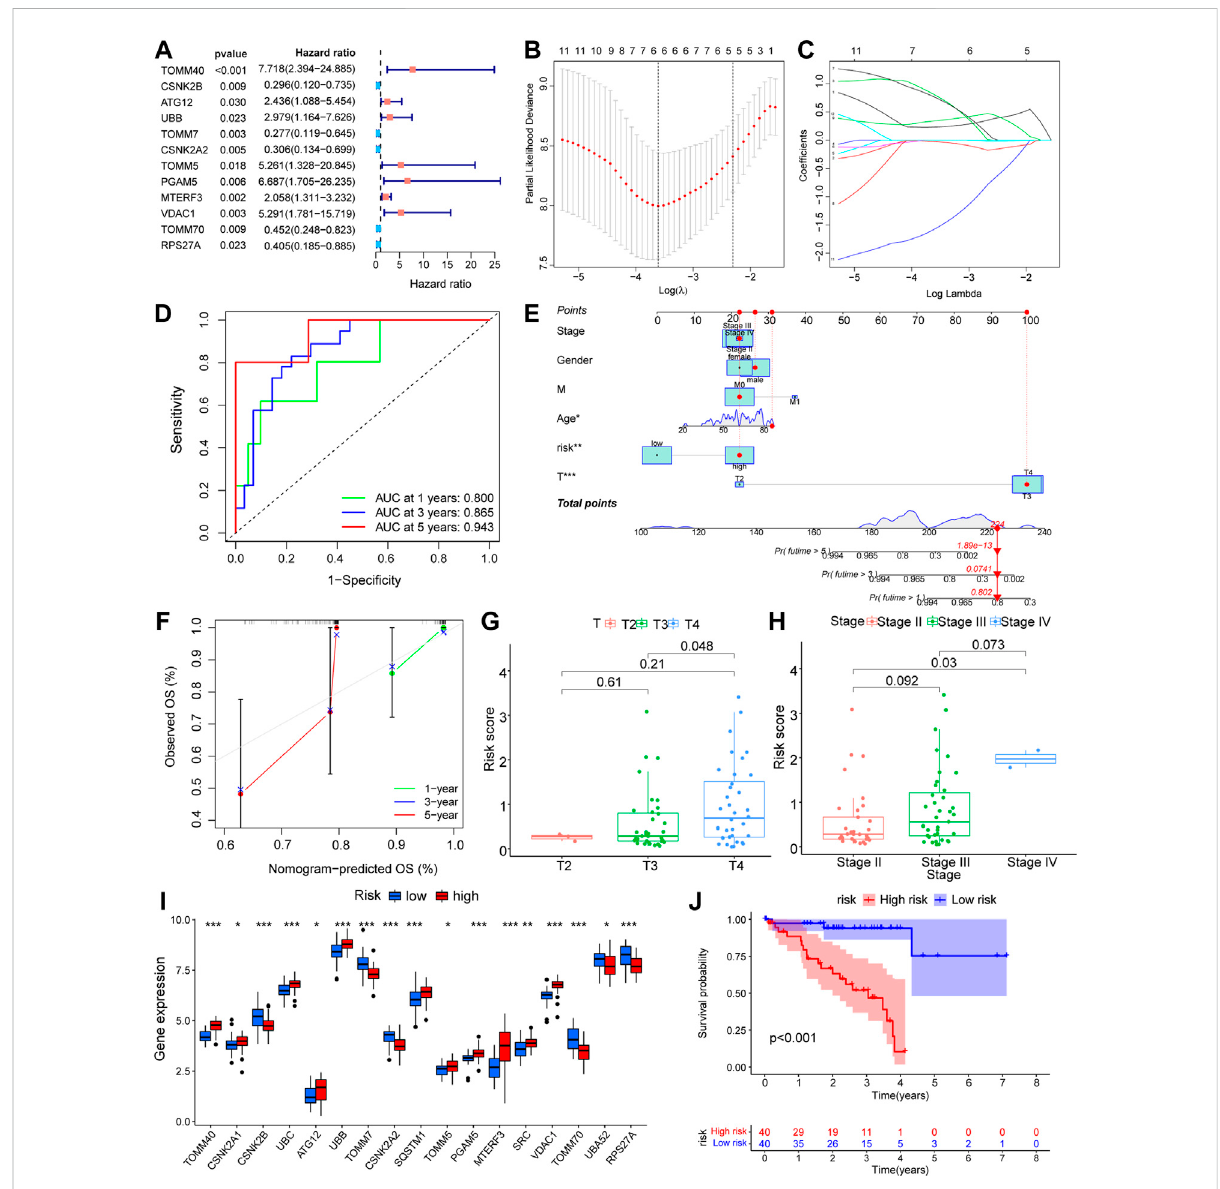
FIGURE 4 Prognosticmodelconstructionbasedonmitophagy-relatedgenes. (A) ForestdiagramshowingtheresultsofCOXregressionanalysisbasedon mitophagy-related genes. (B,C) Prognostic model (B) and variable trajectory (C) of LASSO regression analysis model based on mitophagy-related genes. (D) Time-dependent ROC curve results of Riskscore of LASSO model are shown. Green is the AUC of patients who survived one year, blue is theAUC ofpatients whosurvivedthree years,andredistheAUC ofpatientswhosurvived fi veyears. (E,F) Nomogramresultsofdifferentclinical variables combined with LASSO model Riskscore high and low groups (E) and results of 1-year, 3-year, 5-year calibration curve analysis (F) . (G,H) Difference analysisgroupcomparisonchartresultsofLASSOmodelRiskscoreindifferentTstages (G) anddifferentstagestages (H) . (I) Theresultsof analysis of the differences in expression of mitophagy-related genes between high and low Riskscore groups in the LASSO model are shown in the group comparison chart, where blue isthe low-risk group and red isthe high-risk group. (J) KM curve results of survival analysis of theLASSO model with high and low Riskscore groups, blue is the low -risk group and red is the high-risk group. The closer the AUC in ROC curve was to 1, the better the diagnostic effect was. The AUC has low accuracy when it is between 0.5 and 0.7. The AUC has a certain accuracy between 0.7 and 0.9. The accuracyishigherwhentheAUCisabove0.9.Ns,notsigni fi cant;*, p < 0.05;**, p < 0.01;***, p < 0.001.LASSO,leastabsoluteshrinkageandselection operator; KM, Kaplan – Meier; ROC, receiver operating